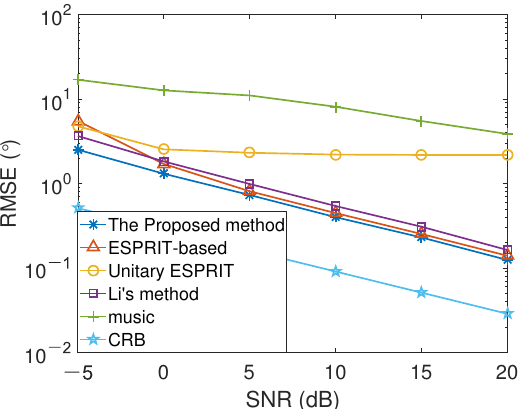
Figure 4. Angle estimation RMSE performance versus SNR, L = 50.